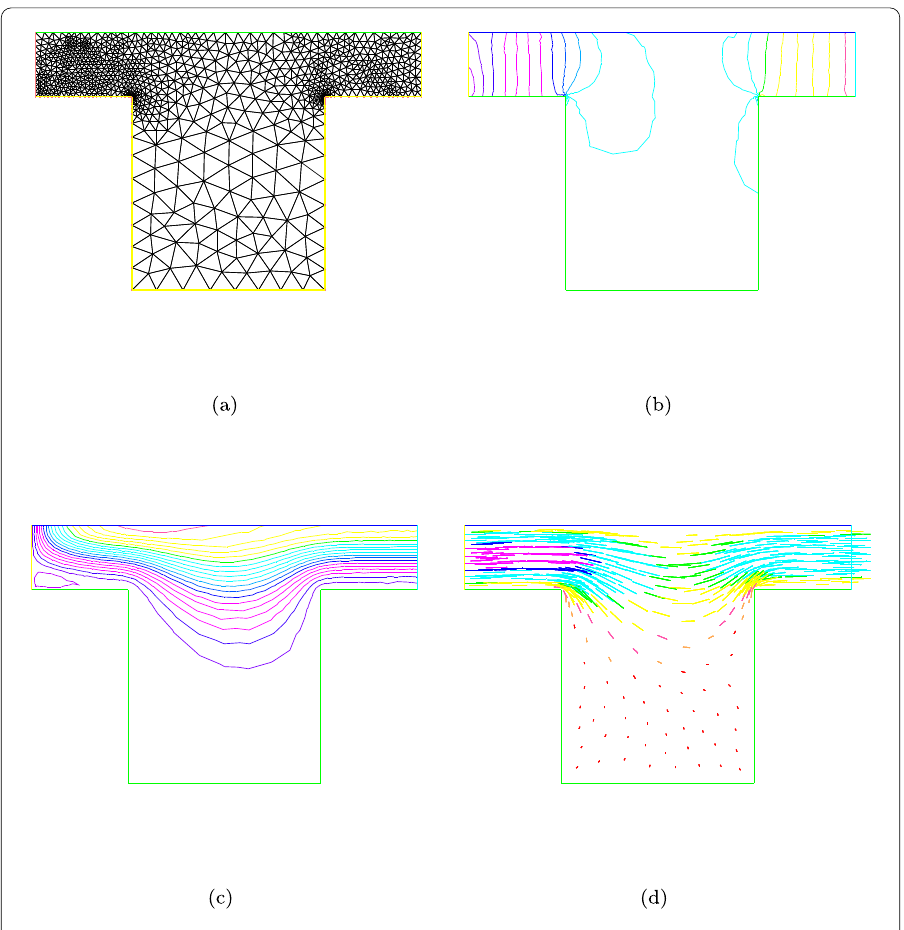
Figure 7 The mesh, the profiles of pressure and velocity, and the velocity vector with NT =